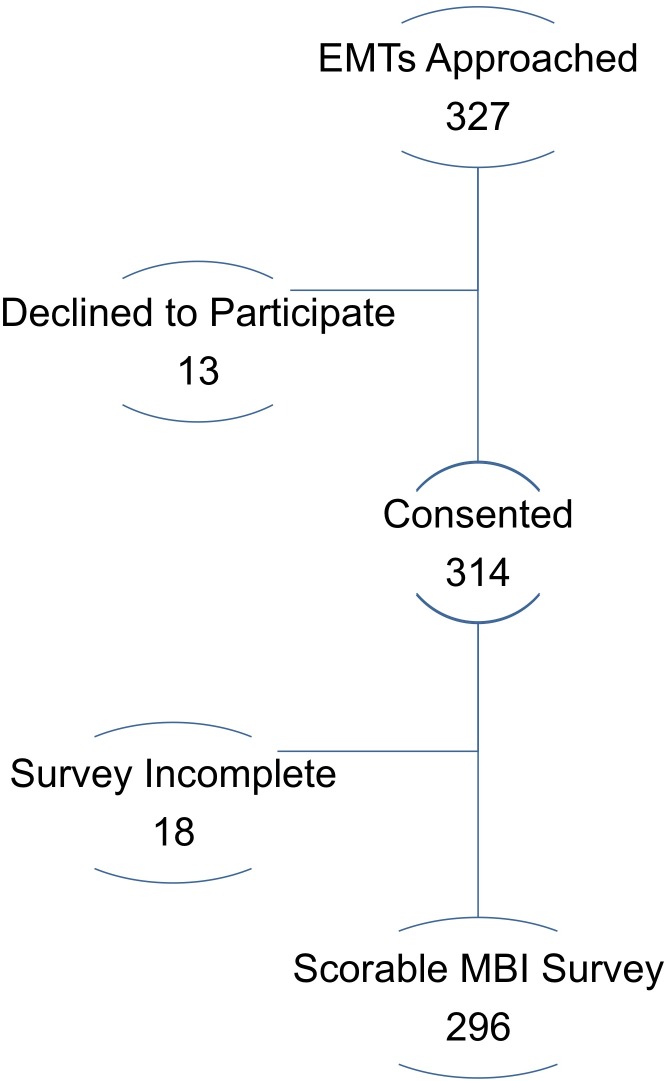
EMT participation.